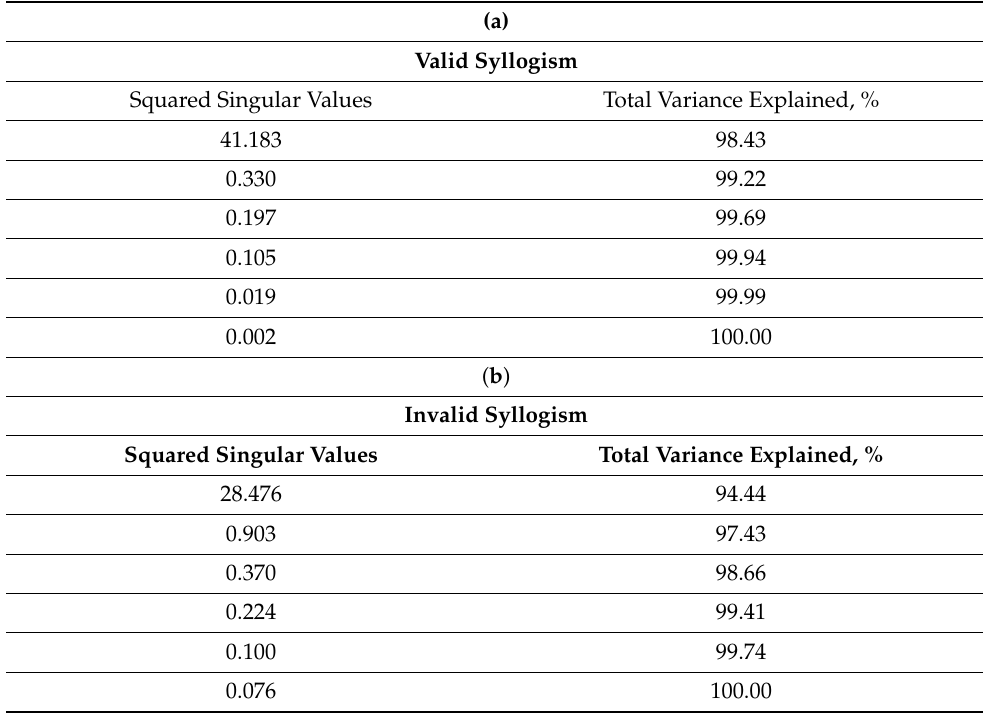
Table 11. ( a ) Singular values and explained variance from seed-PLS for the valid syllogism. ( b ) Sin- gular values and explained variance from seed-PLS for the invalid syllogism.